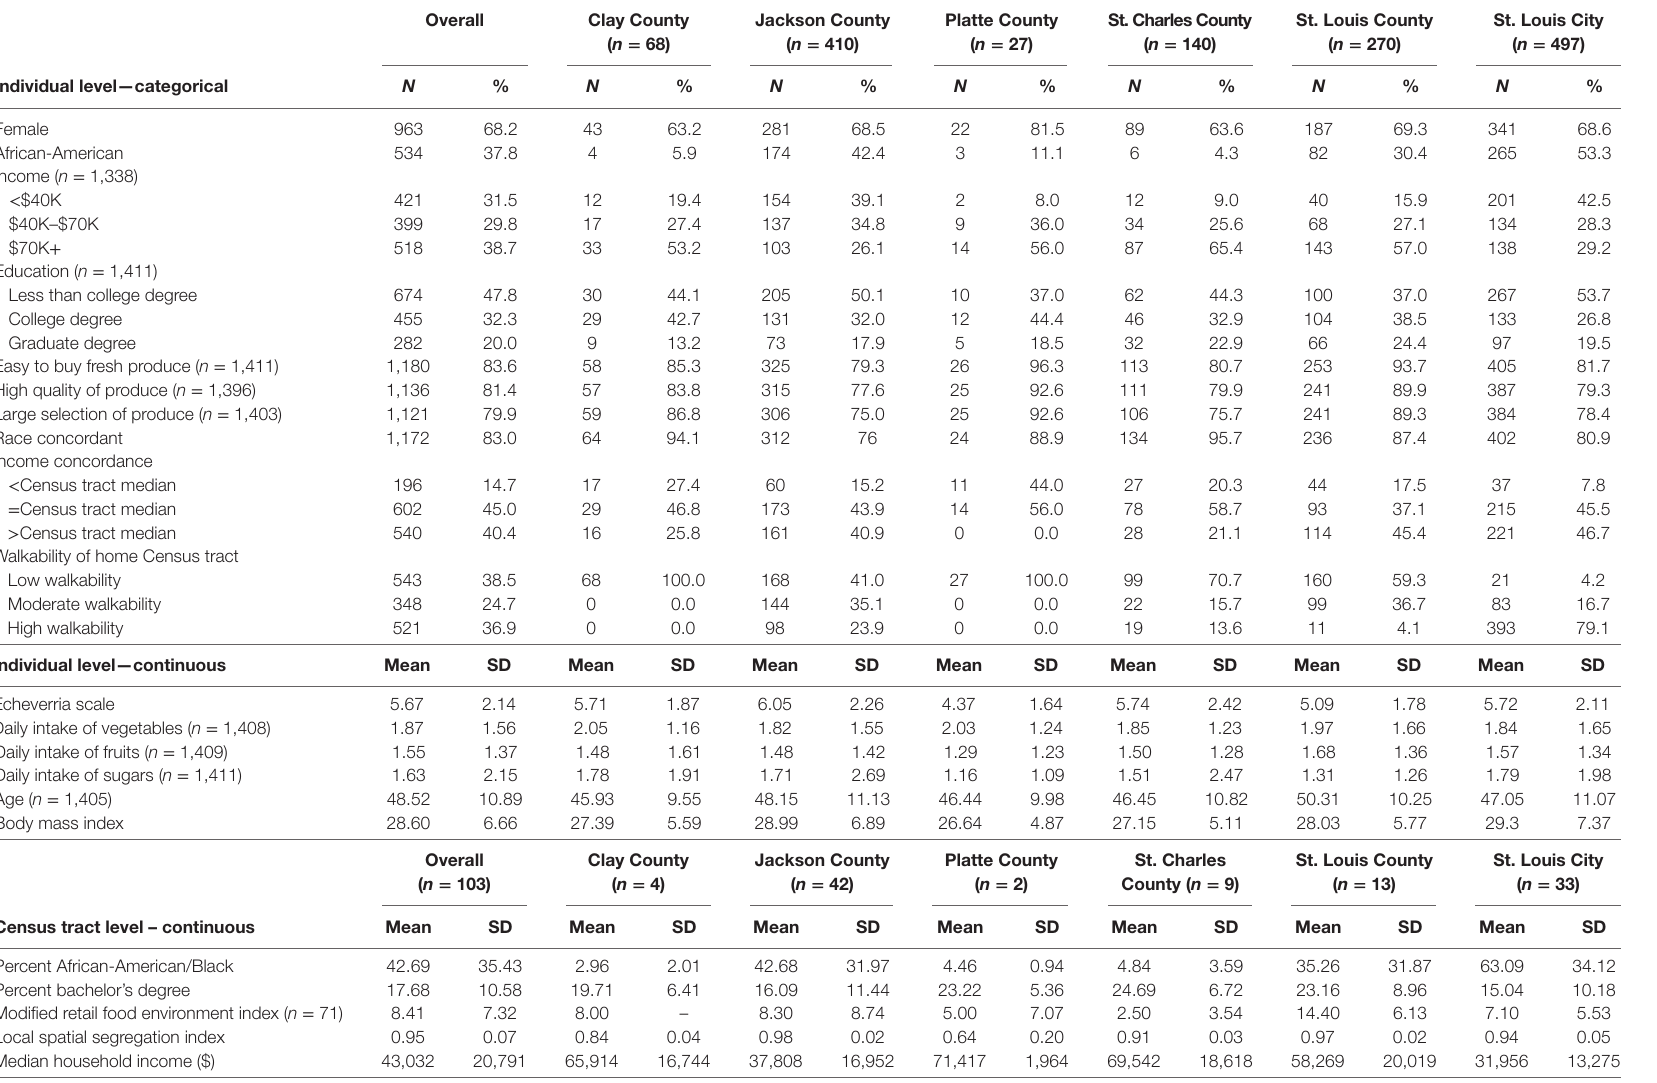
TaBle 1 | Demographics and area level descriptors of the sample ( n =